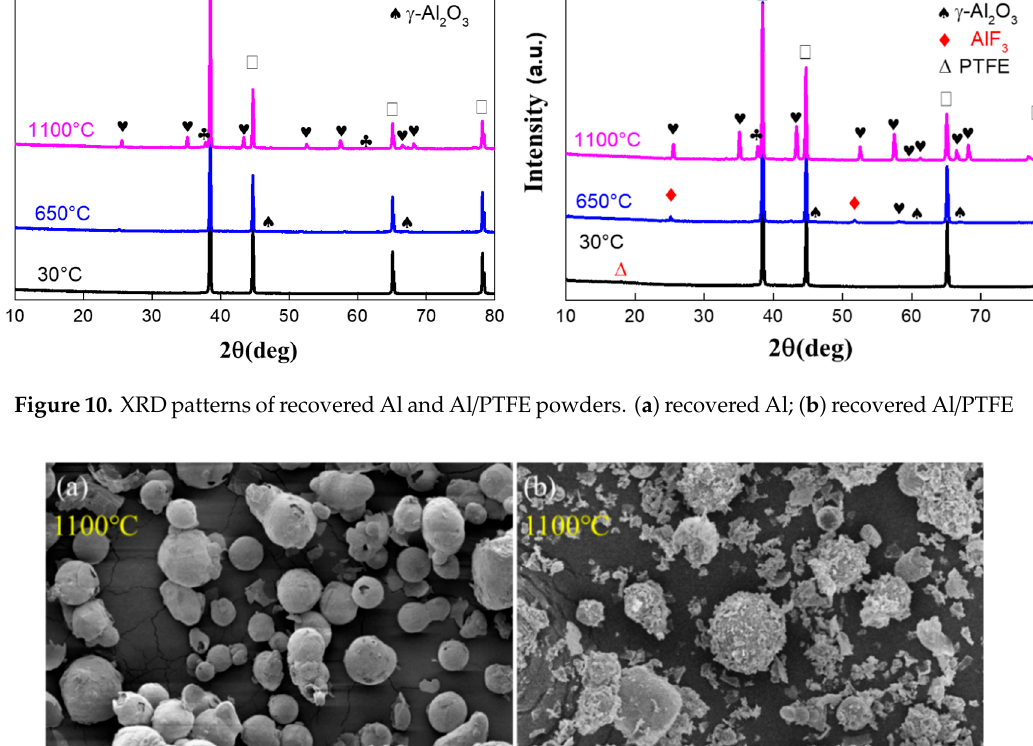
Figure 11. SEM graphs of recovered Al ( a ) and Al/PTFE ( b ) powders at 1100 °C. The samples were recovered from TGA analysis.